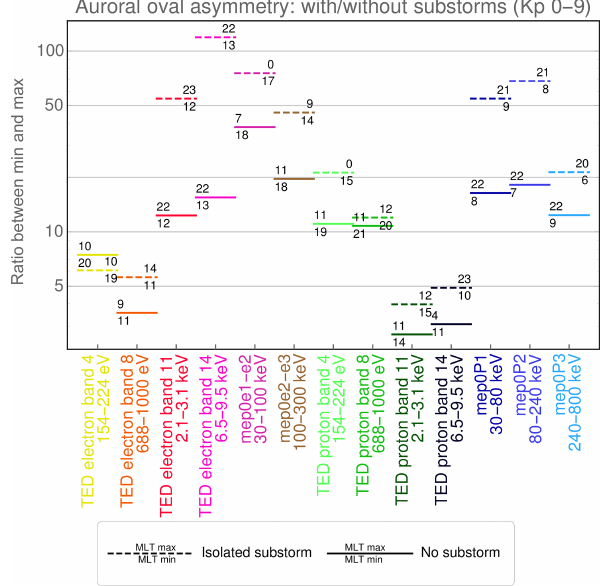
Figure 6. The auroral asymmetry is shown as a ratio between max- imum and minimum auroral oval fluxes. The number above a spe- cific ratio states the MLT where the maximum is detected, while the number below that ratio indicates the MLT of the